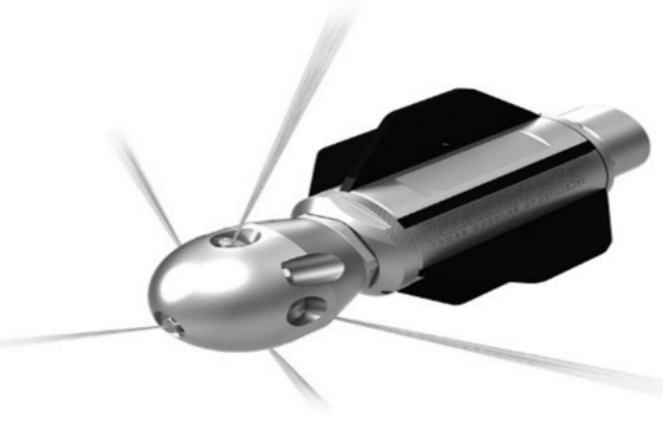
Figure 7. Water jet nozzle.